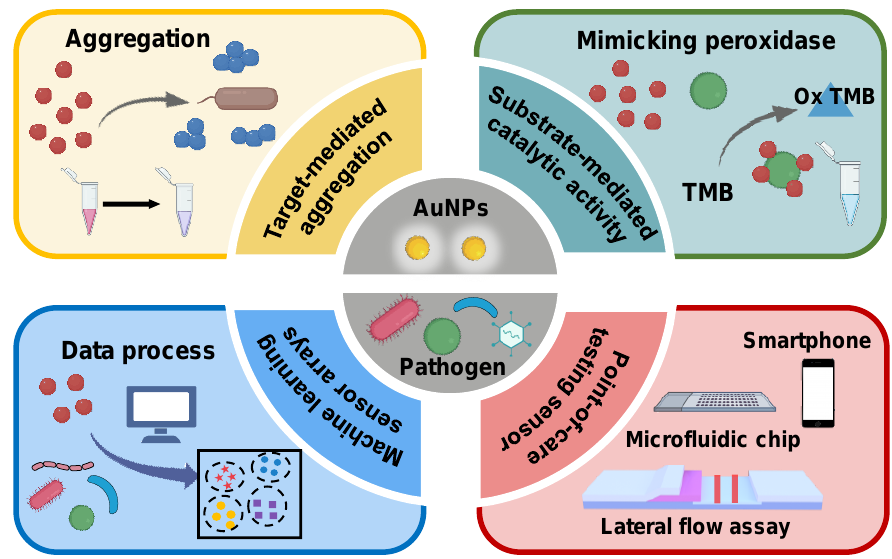
Figure 1. Schematic representation of colorimetric sensors for pathogen identification based on functionalized AuNPs.